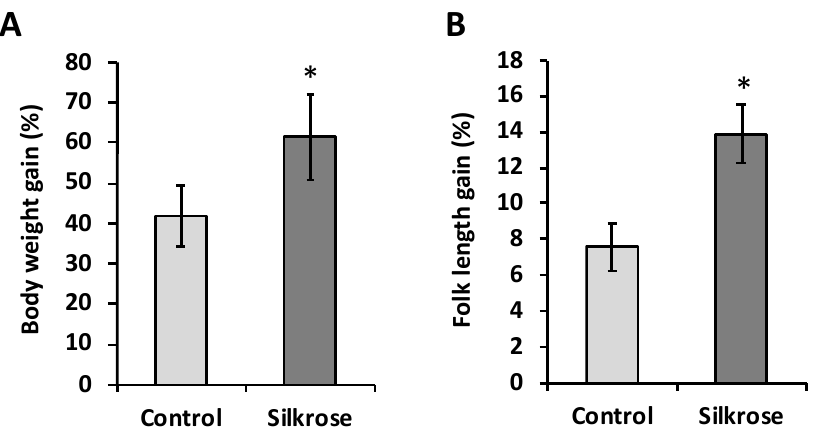
Figure 2. Effect of silkrose treatment on ( A ) body weight and ( B ) fork length gain rate of yellowtail during parasitic challenge experiment. Results are presented as mean ± standard error. Asterisk indicates statistically significant differences versus control group (* p < 0.05).